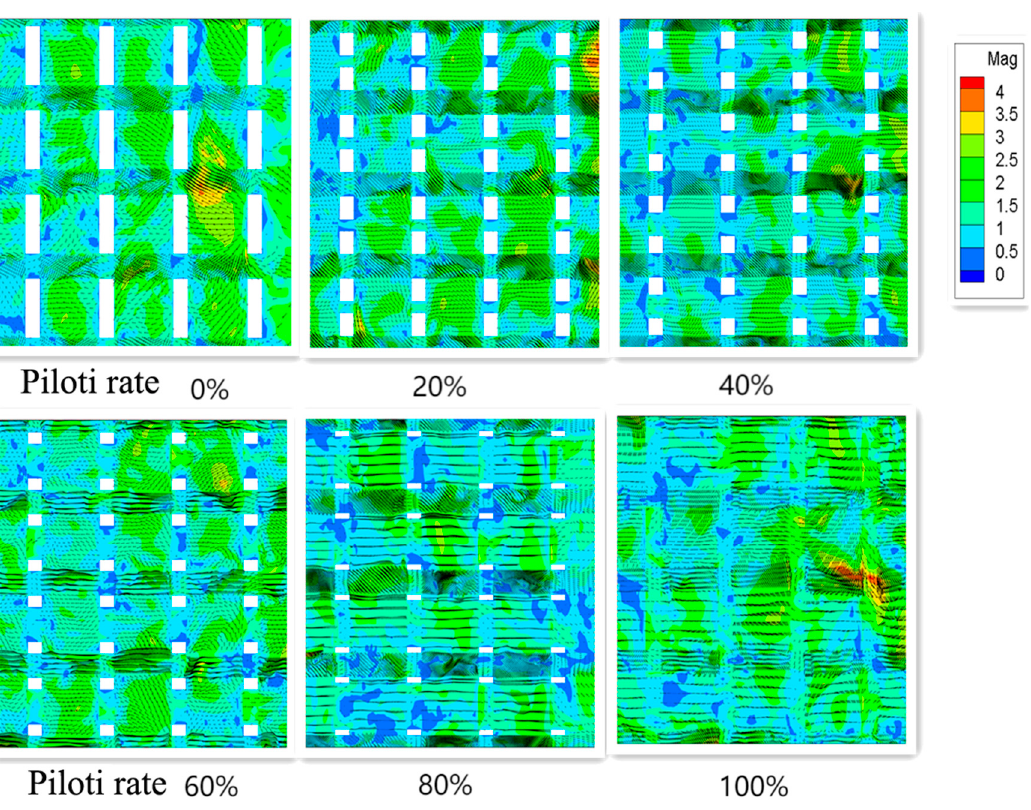
Figure 8. Vector diagram of the target area of a pedestrian layer.